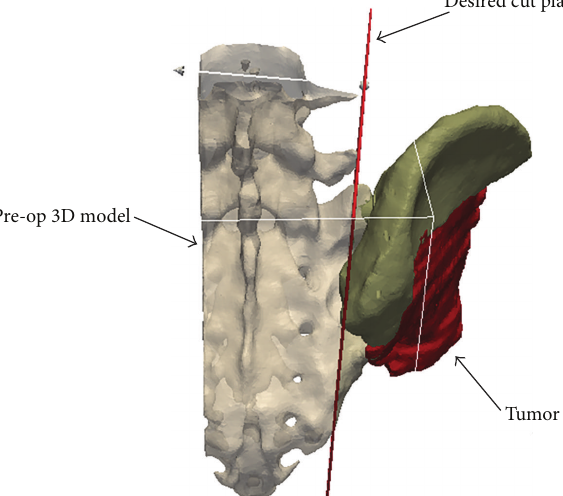
Figure 1: Preoperative planning for patient number 2. Preoperative CT images of the patient were segmented to construct the 3D virtual modelsofthepatientandthetumor.Theresectionstrategyconsisted of one target plane defining the desired resection plane with a 6 mm safe